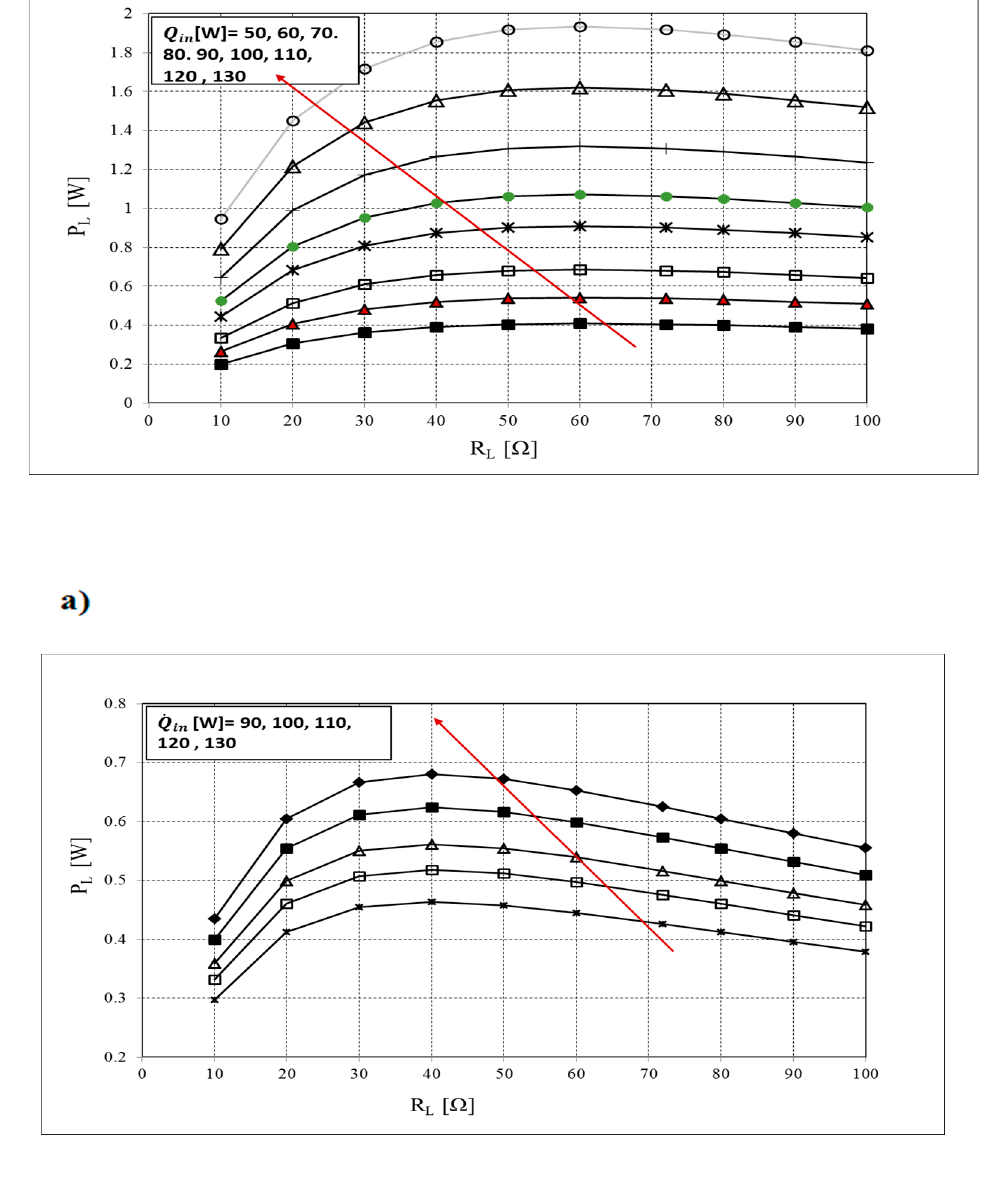
Figure 12. E ff ect of load electrical resistance (R el,L ) ( a ) case A ( b ) case Figure 12. Effect of load electrical resistance (R el,L ) ( a ) case A ( b ) case B .